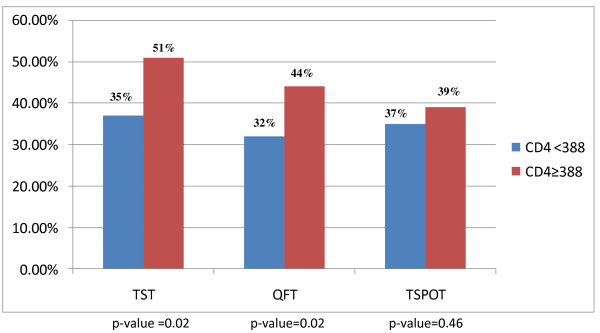
Positive diagnostic test for latent tuberculosis infection stratified by CD4 count (n = 298).